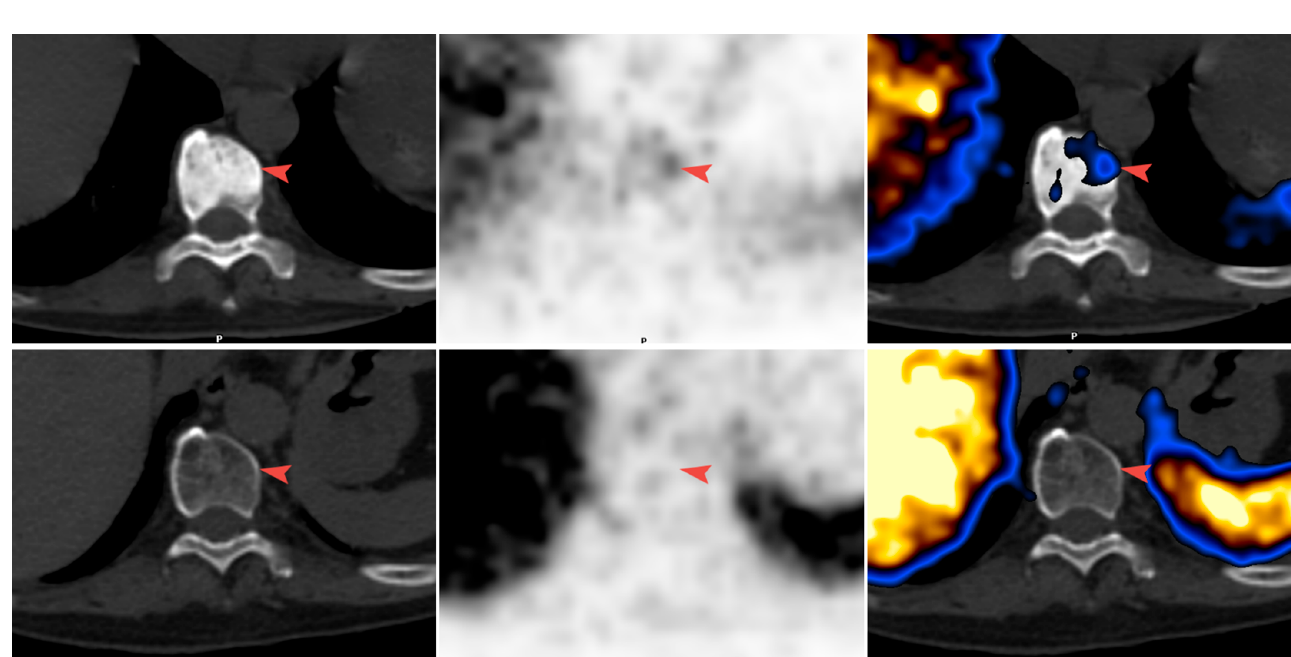
Figure 1. Disease response (Patient 7). (From left to right) CT; PET; and fusion images. In the first scan after ADT and bisphosphonate treatment, sclerotic metastasis in the vertebra was identified with very low uptake of 68Ga-PSMA-11 (arrowhead) (top row). In the second scan after ADT, the vertebra was no longer sclerotic and showed no uptake (bottom row). PSA levels were reduced and there was no evidence of new disease.